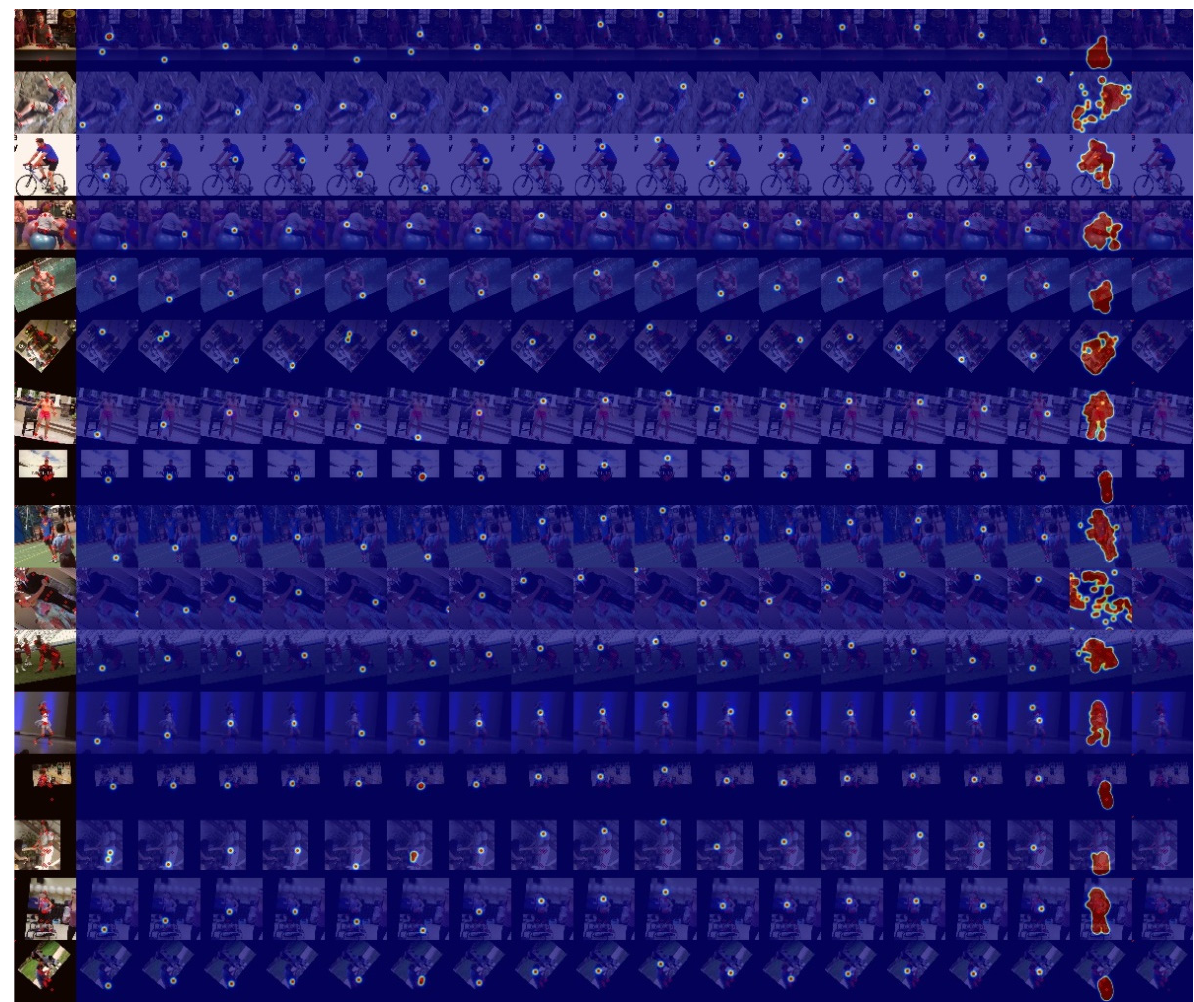
Figure 4. Cofopose trade-off accuracy speed for keypoint detection with ResNet-101 as a backbone with a higher resolution of 512 × 512 for 75 epochs, when used on the MPII dataset.